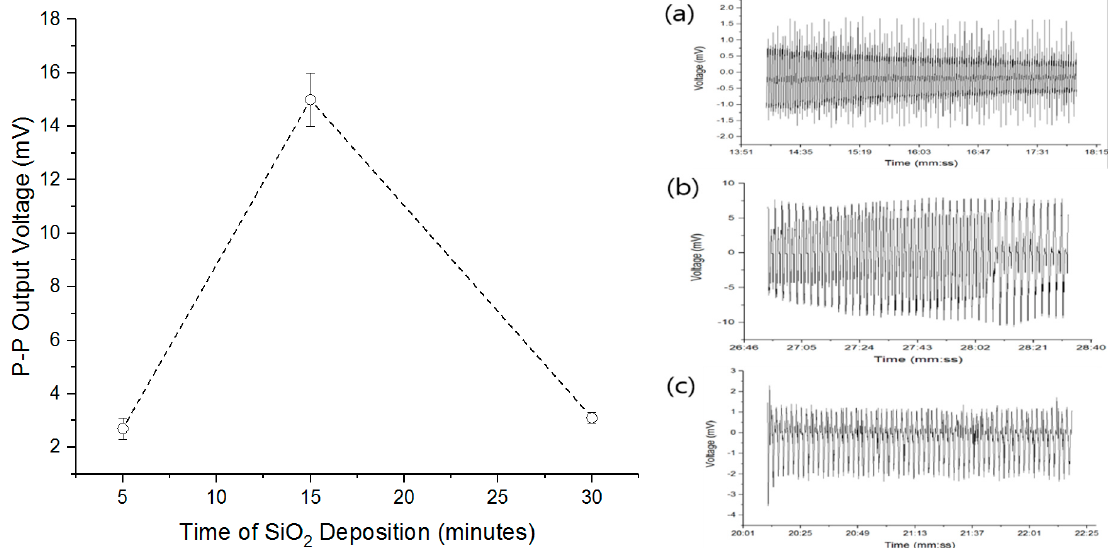
Figure 6. ( Left ) Peak to peak (P–P) output voltages of three ZSZ ‐ MGs as a function of the SiO 2 deposition time (Average deposition rate of SiO 2 = 3.85 nm/min, ZnO = 4.48 nm/min at 200 W deposition power). ( Right ) Output voltage variations of three ZSZ ‐ MGs with SiO 2 thin films deposited for ( a ) 5 min, ( b ) 15 min, and ( c ) 30 min, respectively.